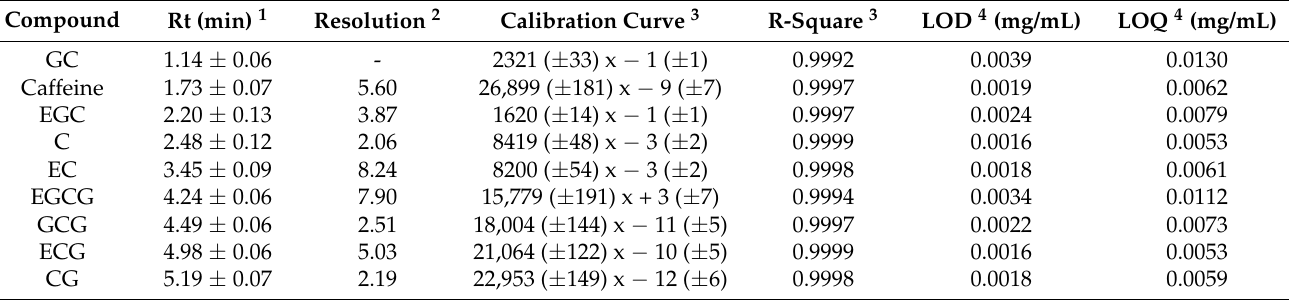
Figure 1. HPLC chromatograms for a standard mixture ( a ) and a green tea sample prepared with deionized water ( b ). Table 1. HPLC performance parameters.